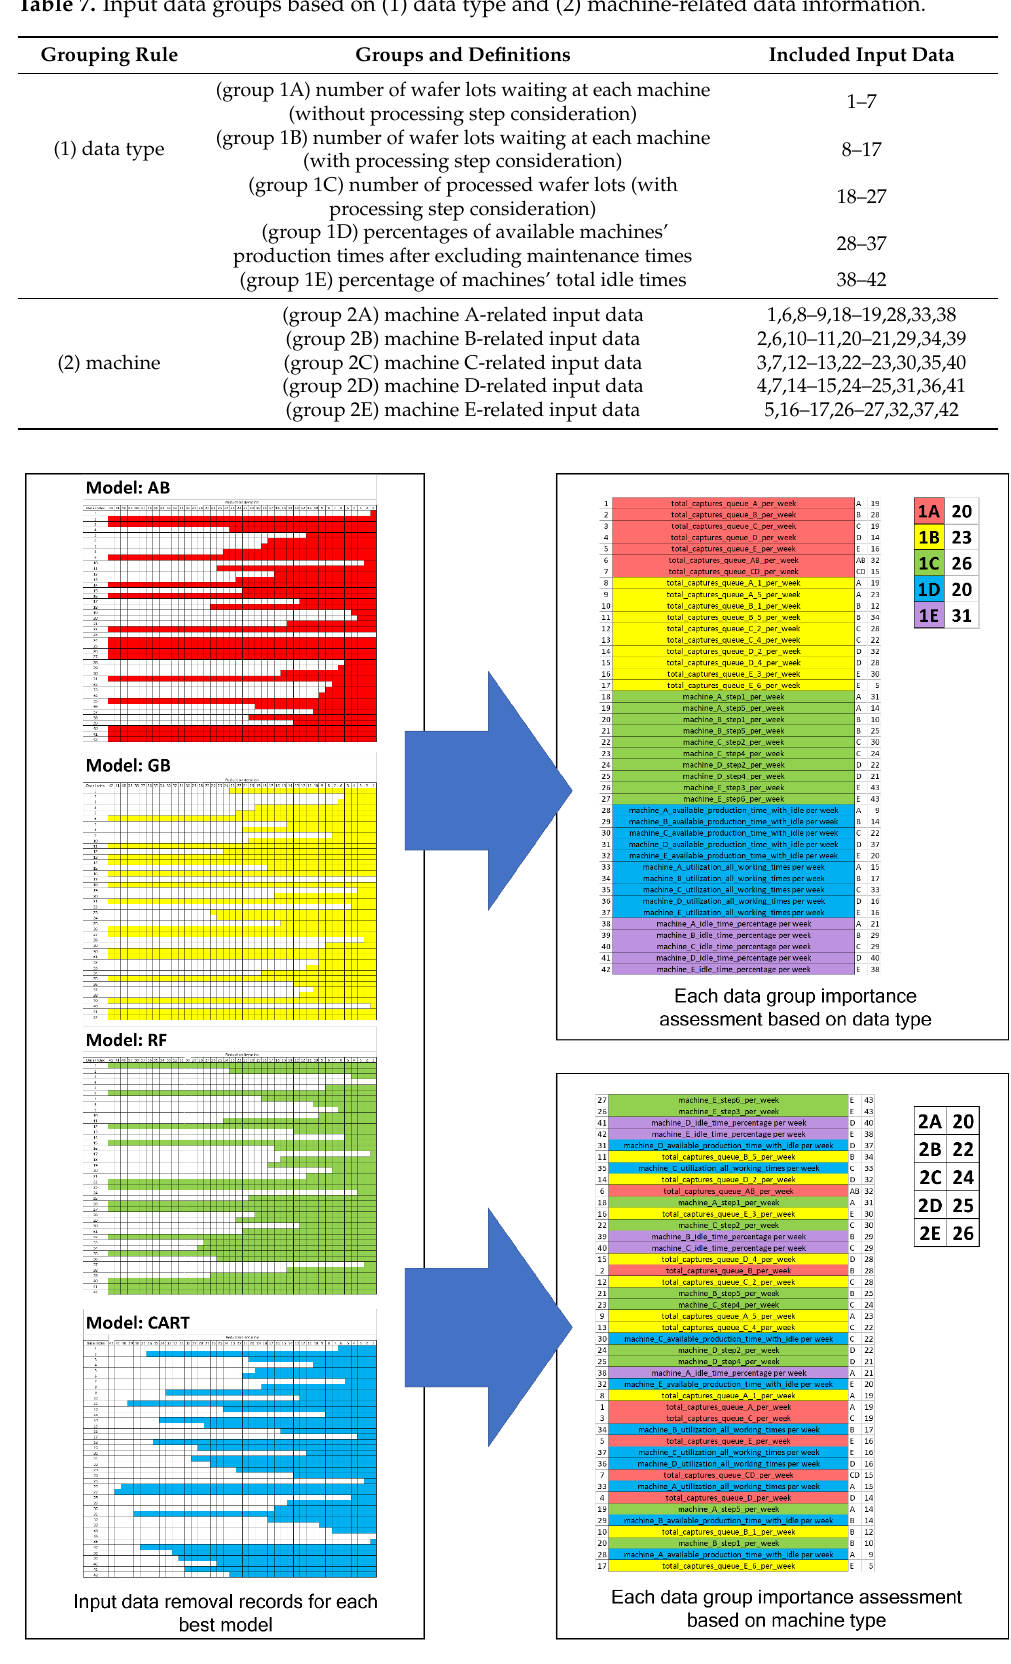
Figure 6. Framework for analysis of each data group’s importance based on data and machine types.